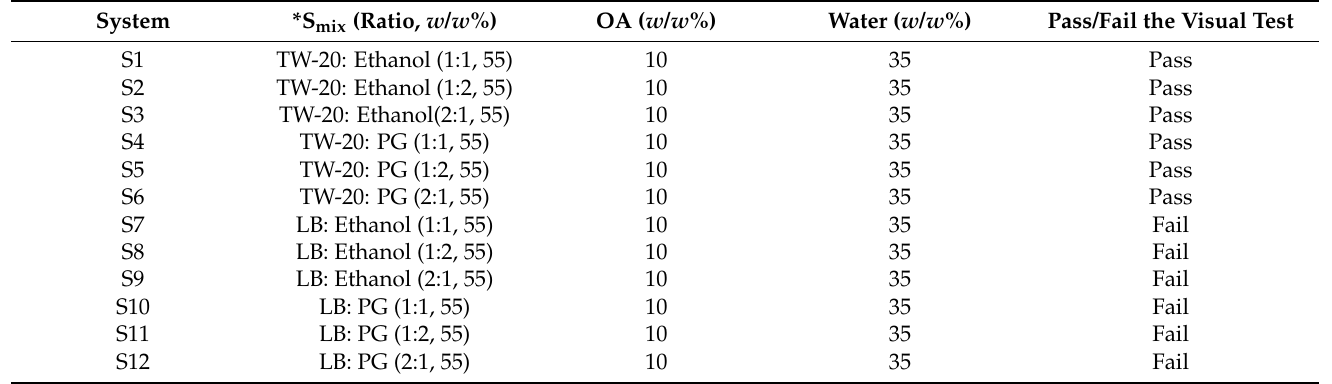
Table 1. Composition and visual testing of the pseudoternary systems.